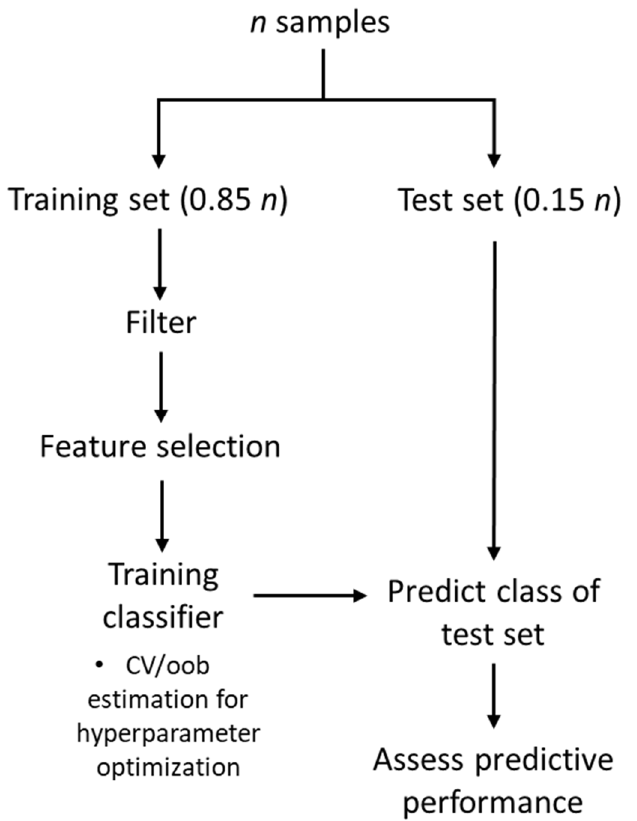
Figure 7. Workflow employed for filter-based feature selection and classification. CV = cross-validation; oob = out-of-bag.